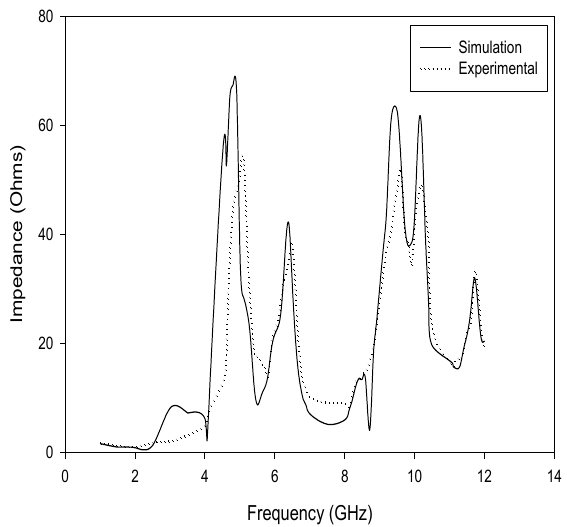
Figure 6. Simulation and Experimental variation of Impedance with frequency (with